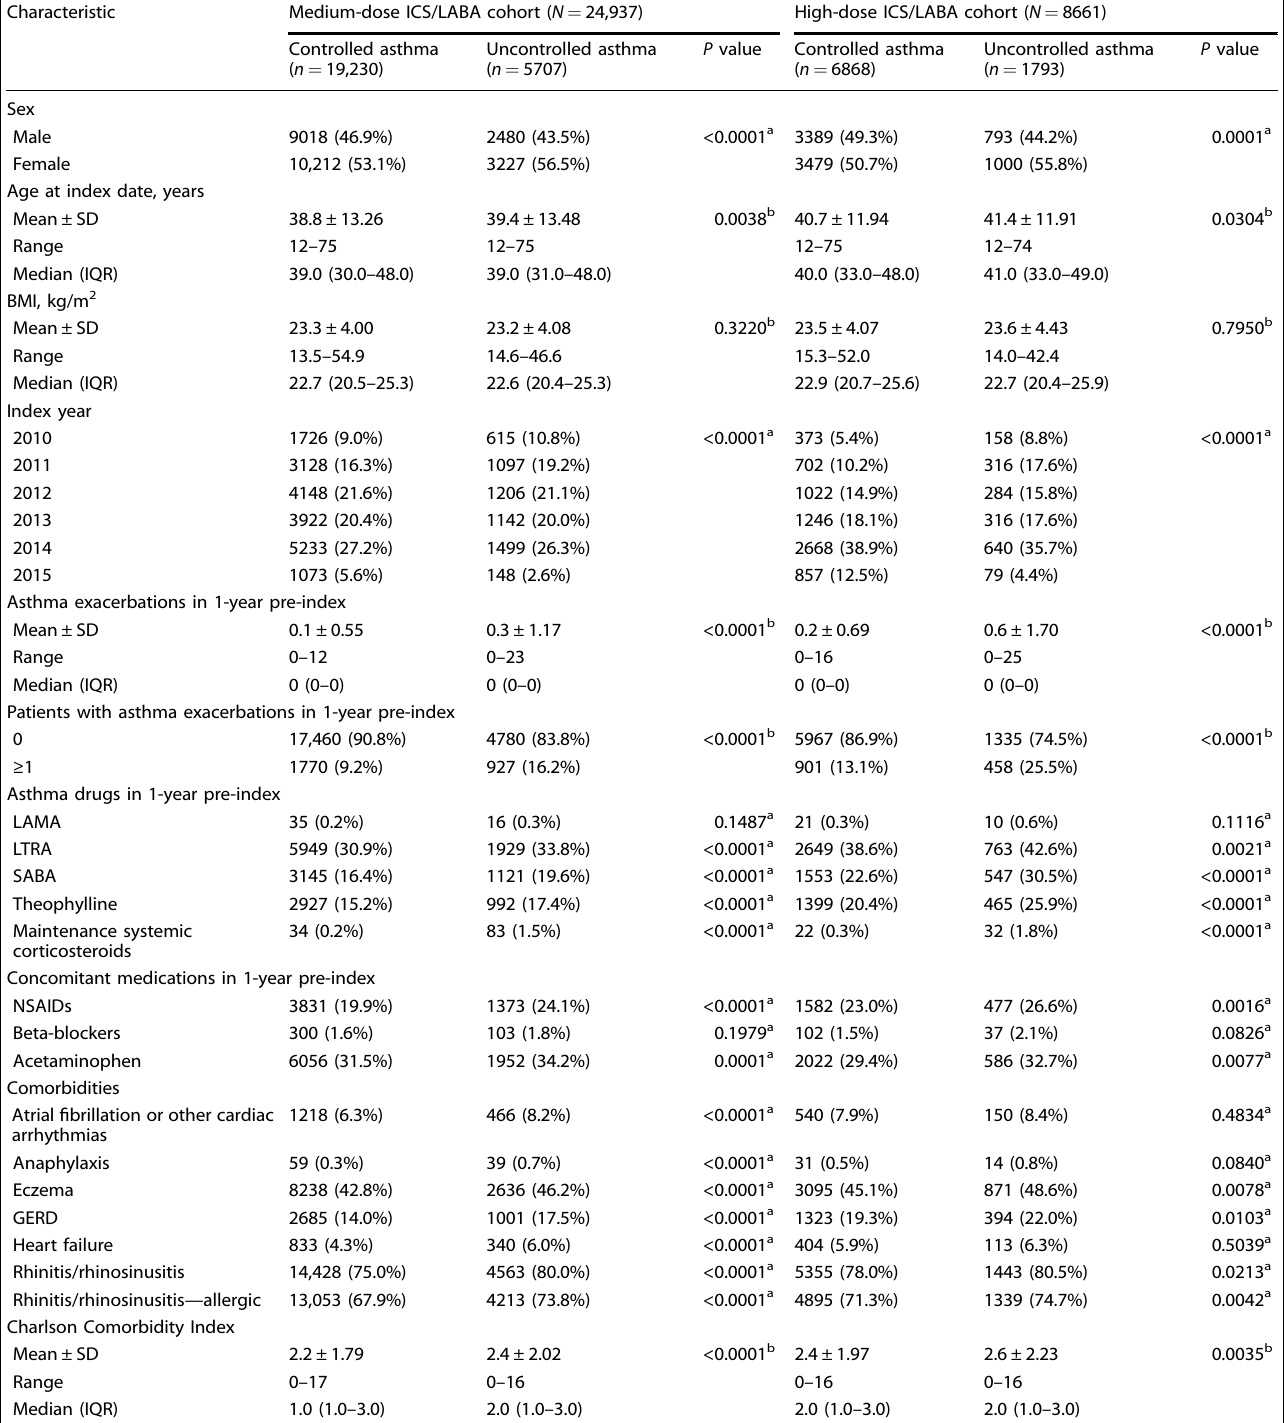
Table 2. Demographic and clinical characteristics of patients achieving asthma control versus patients with uncontrolled asthma in the post-index